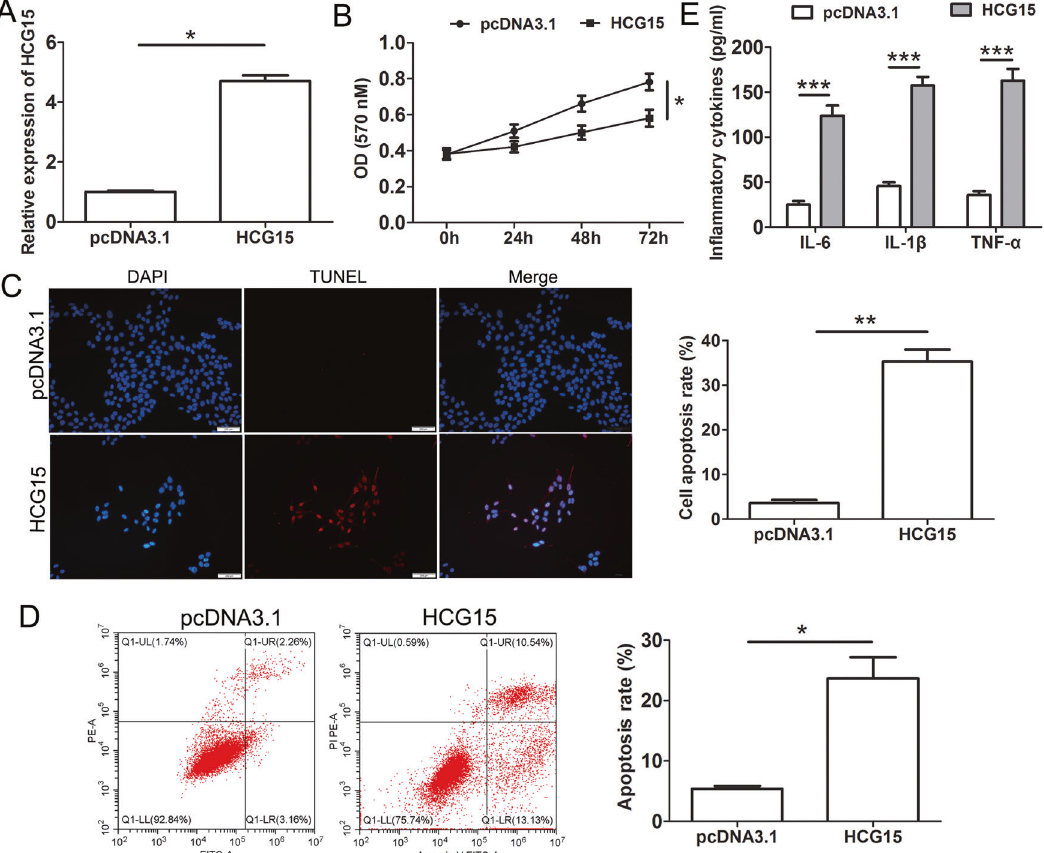
Fig. 2 LncRNA HCG15-induced cardiomyocytes apoptosis and the production of in fl ammatory cytokines. A qRT-PCR was performed to examined HCG15 expression in AC16 cells after transfection of the HCG15 overexpression plasmid. B MTT assays detected the proliferation of AC16 cells after transfection of the HCG15 overexpression plasmid. TUNEL staining ( C ) and fl ow cytometry ( D ) were performed to measure the apoptosis of AC16 cells after transfection with the HCG15 overexpression plasmid. E The production of in fl ammatory cytokines of AC16 cells transfected with the HCG15 overexpression plasmid was measured by ELISAs. * p value < 0.05, ** p value < 0.001, *** p value < 0.001. Each assay was performed in